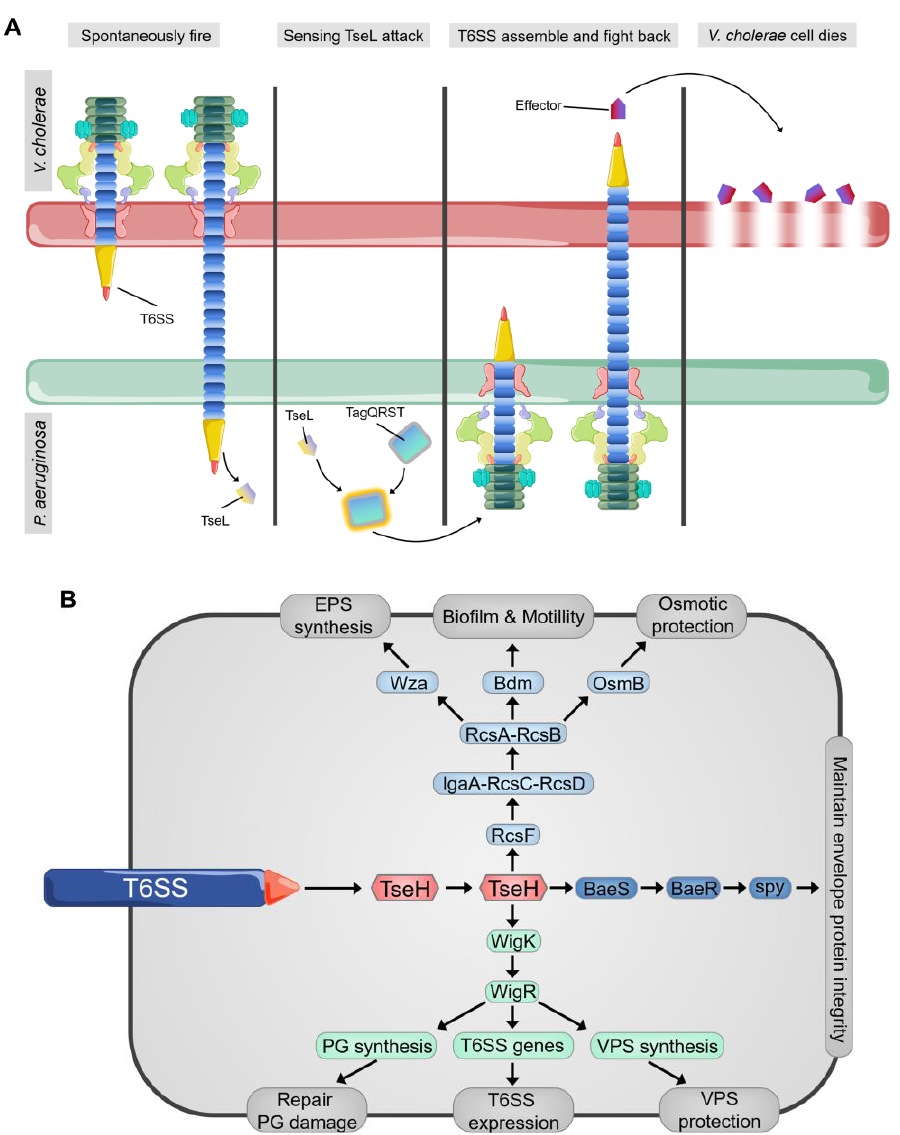
Figure 5. ( A ) Spontaneous firing from V. cholerae T6SS and retaliatory attack from P. aeruginosa . TagQRST cascade senses T6SS-delivered TseL and induces a counterstrike in P. aeruginosa . ( B ) After sensing the effector attack of T6SS, E. coli and V. cholerae induce envelope stress response through Rcs phosphorelay and BaeSR (blue) or WigKR (green). The induced genes produce protective effects in different ways. PG, peptidoglycan. EPS, exopolysaccharides. VPS, Vibrio